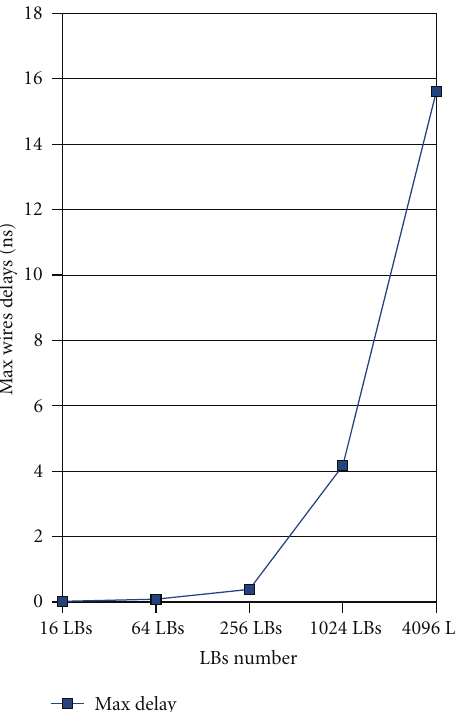
Figure 16: Maximum wire lengths depending on Tree size (arity 4). Figure 17: Maximum wire delays depending on Tree size (arity